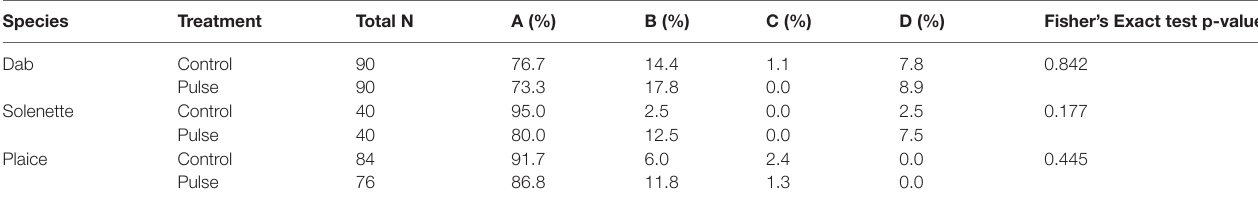
TABLE 5 | Frequencies of vitality classes A-D (% of total number of observation, N) for plaice, dab and solenette sampled from pulse trawl tracks (Pulse) and unfished control areas (Control). Species